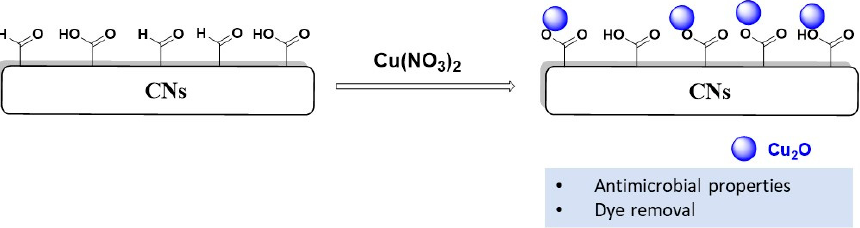
with dye removal and antimicrobial properties. The scheme presents the reaction between Cu (II)